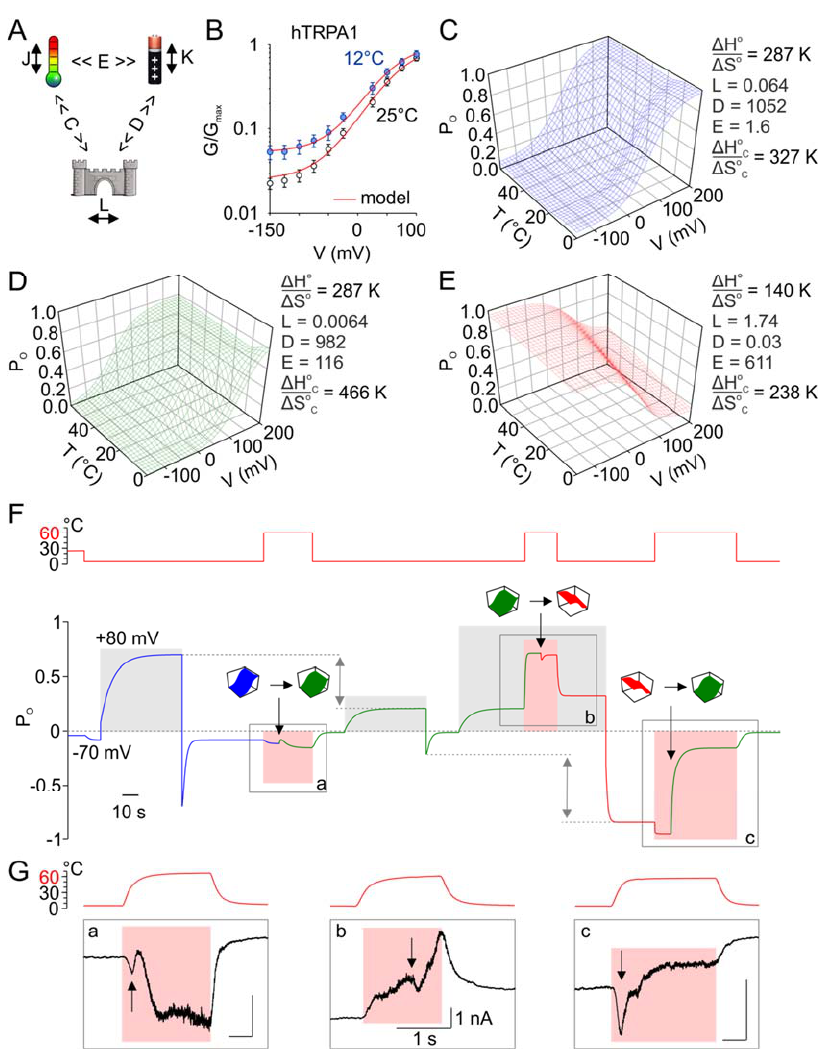
Figure 8. The eight ‐ state allosteric model is adequate for explaining the variability in TRPA1 temperature responsiveness. ( A ) Allosteric model for temperature- and voltage-dependent activation of TRPA1. The transitions between open and closed states are given by the intrinsic equilibrium constant L . The transitions between resting and active conformations of temperature sensors and voltage sensors are given by equilibrium constants J ( T ) = exp[ − ( ∆ H − T ∆ S ) / RT ] and K = K (0)exp( zFV / RT ), respectively. The coupling of the voltage sensor to the channel gate and to the temperature sensor is governed by the allosteric coupling constants D and E , which are assumed to be temperature-independent. The coupling of temperature sensor to the channel opening is assumed to be temperature-dependent by the term C ( T ) = exp[ − ( ∆ H o C − T ∆ S o C ) / RT ]. ( B ) Normalized conductance of hTRPA1 (same as in Figure 1B) at the indicated temperatures. Red lines are the global fit by using the model in ( A) . Parameters of the fit were used to plot open probability landscape in ( C ); for details, see Materials and Methods. ( C ) Open probability landscape obtained by calculating P o as a function of temperature and voltage by using the parameters from fit in ( B) : K (0) = 0.003, z = − 0.74, ∆ H o C = 6.1 kcal mol − 1 and value ∆ H = 91 kcal mol − 1 published for TRPM8 [39]. Note a mild U-shape thermosensitivity. ( D ) ‘Irreversible switch-after-excessive heat‘ mechanism. Exposure to heat over 60 ◦ C triggers the reduction of currents at + 80 mV (as in Figure 6A,C). Open probability landscape was remodeled to qualitatively match the activation profile of hTRPA1, as shown in Figure 7A. The parameters K (0) , z and ∆ H o were preserved from blue P o landscape in ( C ), ∆ H o C = 1.4 kcal mol − 1 . ( E ) Concurrent activation of voltage- and heat-sensor rendered TRPA1 sensitized to cold. The open probability landscape obtained in ( D)